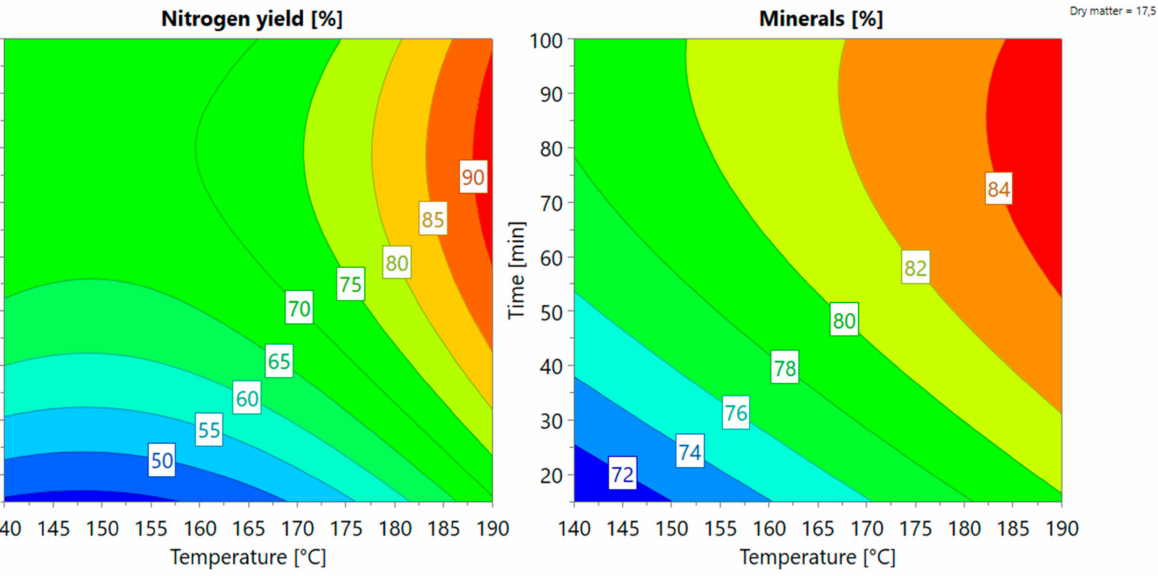
Figure 4. The response surface of the enzymatic hydrolysis model of MDCM clean bones showing the relationships between nitrogen and mineral yield, temperature, and hydrolysis